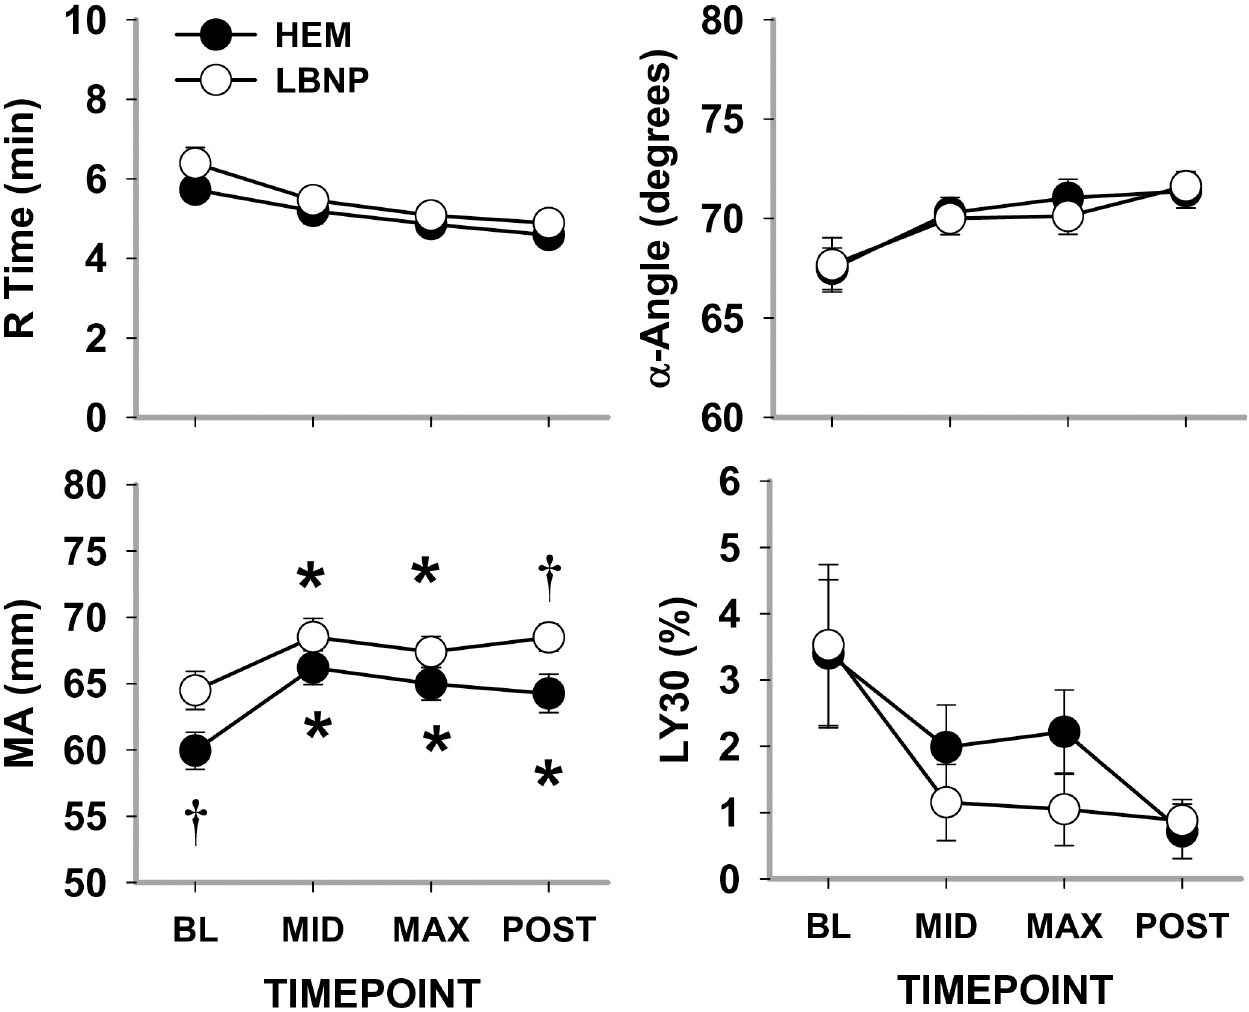
Fig 3. Thromboelastography parameters during HEM and LBNP in anesthetized baboons. Reaction time until initial fibrin formation (R-time), rate of clot formation ( α -Angle); maximal amplitude reflecting clot strength (MA) and clot lysis at 30 min after MA (LY30). Mean ± SE, n = 13; � different from baseline ( P < 0.05); and † different from HEM ( P <